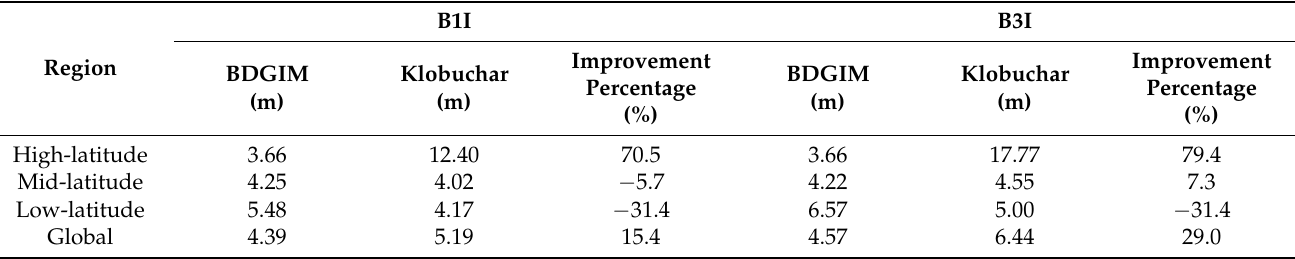
Table 5. Regional and global averages of the 3D accuracies of SPP with the BDGIM and the Klobuchar model for the BDS legacy signals B1I and